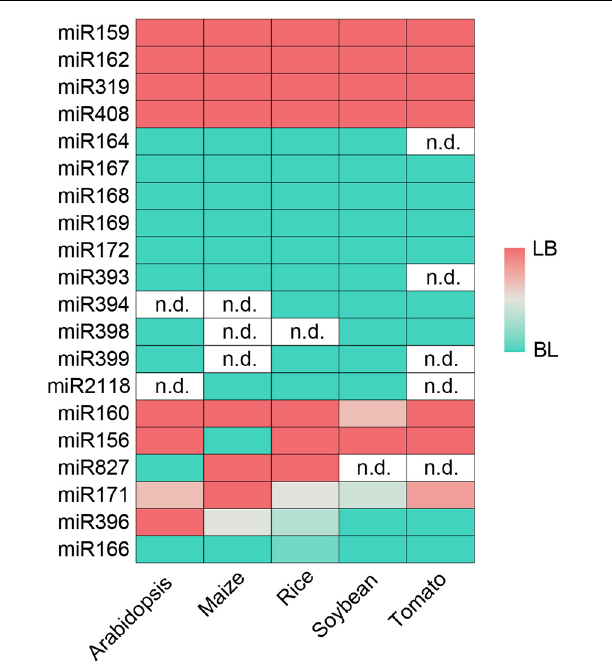
FIGURE 5 | Conservation of miRNA processing modes determined by Parallel Amplification of RNA Ends (PARE). LB, short/sequential loop to base; BL, short/sequential base to loop. The intensity of color reflects the degree of intraspecific conservation. White (n.d.): not determined.